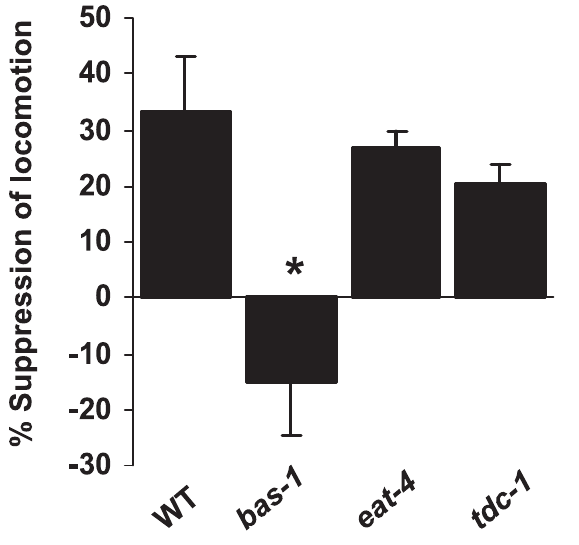
Figure 3. The cocaine-induced hypolocomotor response requires serotonin and depends on SERT/MOD-5. Data are quantified as percentage suppression of locomotion velocity between naı¨ve and cocaine-treated conditions for each genotype. *p , 0.002 (ANOVA with the Bonferroni test comparing mutants and WT). Error bars: SEM.